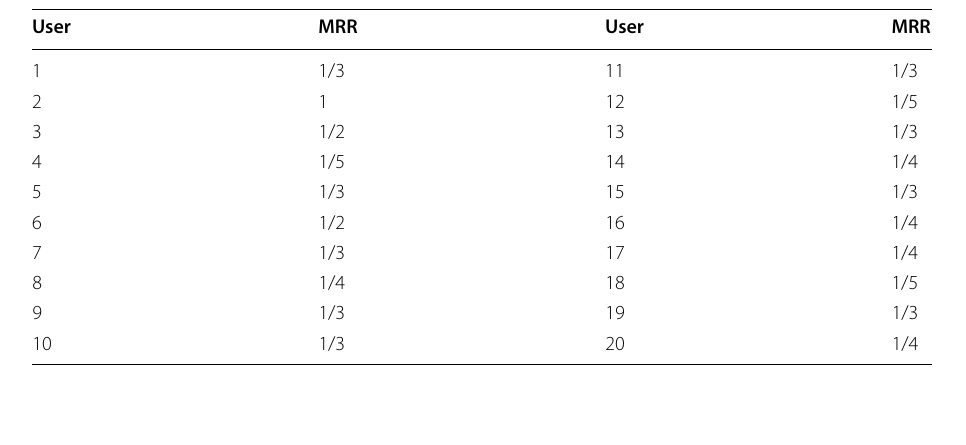
Table 11 MRR based on friend recommendation and A ( P )